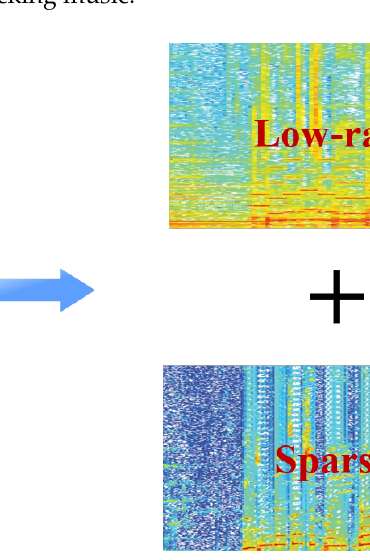
Figure 2. The separation process of SVS with low-rank and sparse